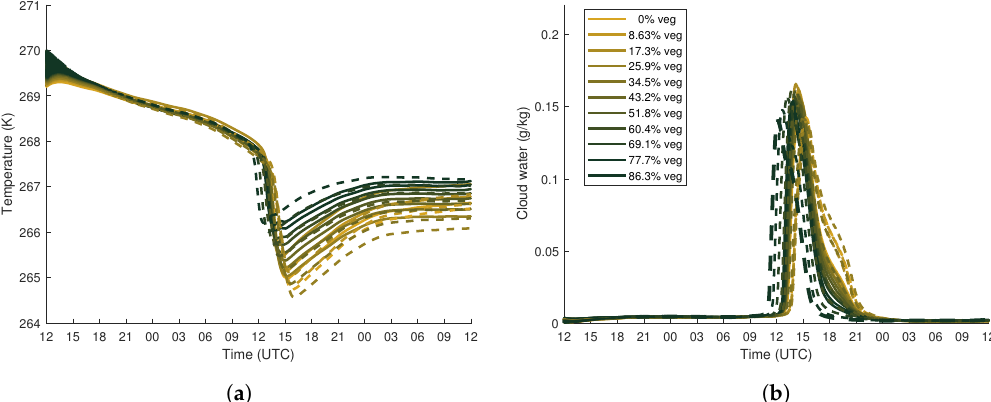
Figure 18. Time evolution of air temperature ( a ) and cloud water ( b ) for the 24 December 2013 case at 117 m for each vegetation